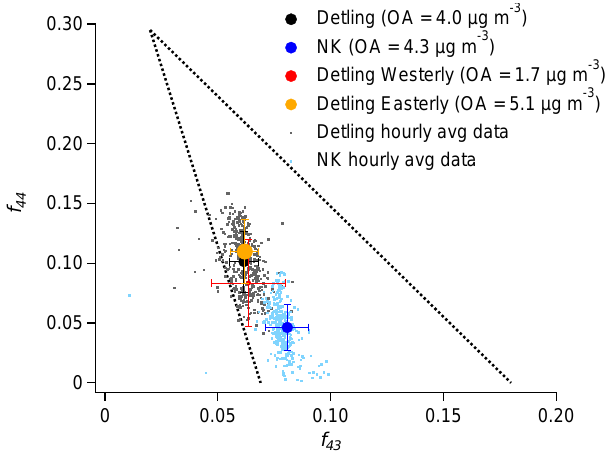
Figure 5. f 44 vs. f 43 for Detling and NK sites, as well as for the westerly sector and easterly sector of the Detling site. The dotted lines were adapted from Ng et al. (2010). The averages are sized by average organic loading. The error bars indicate 1 standard devia- tion. The average OA concentration at the Detling site is different from the value in Fig. 3 due to different sampling periods.